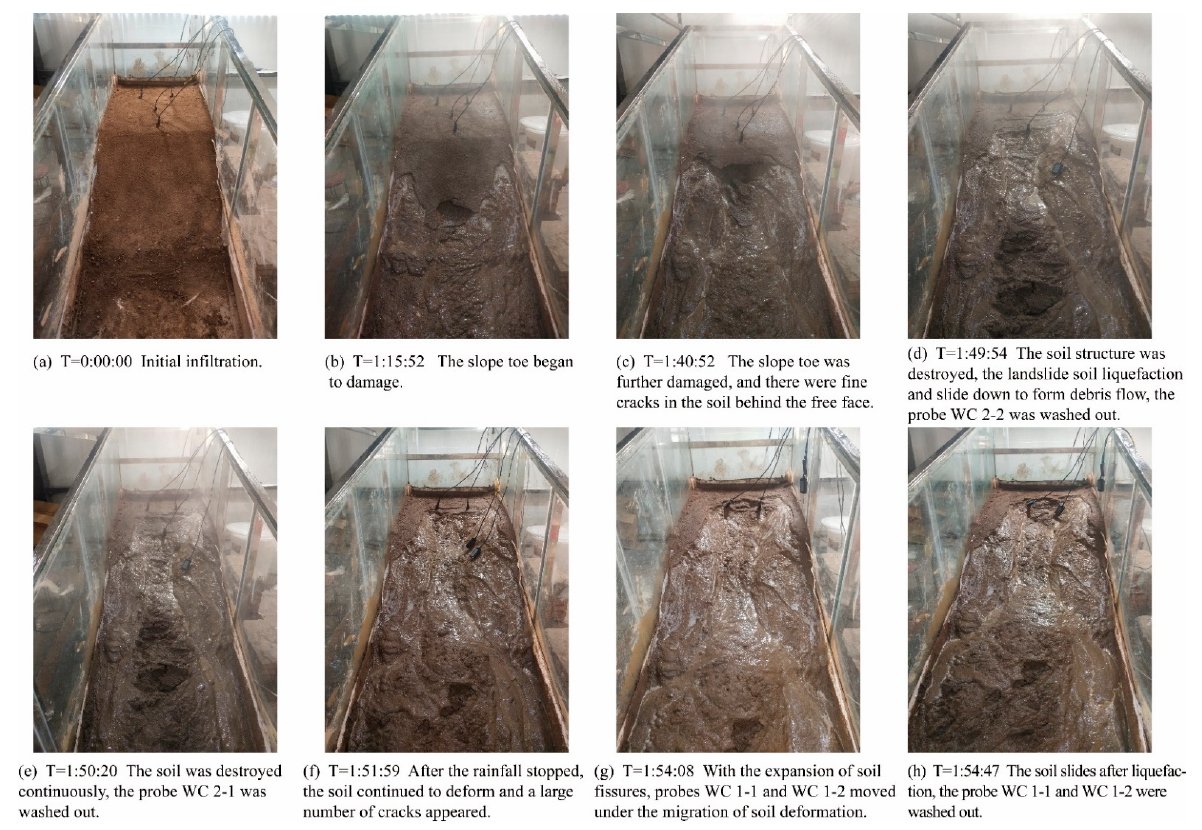
Figure 9. The destruction process of ZJCG gradation under the rainstorm (24.58 mm/h).